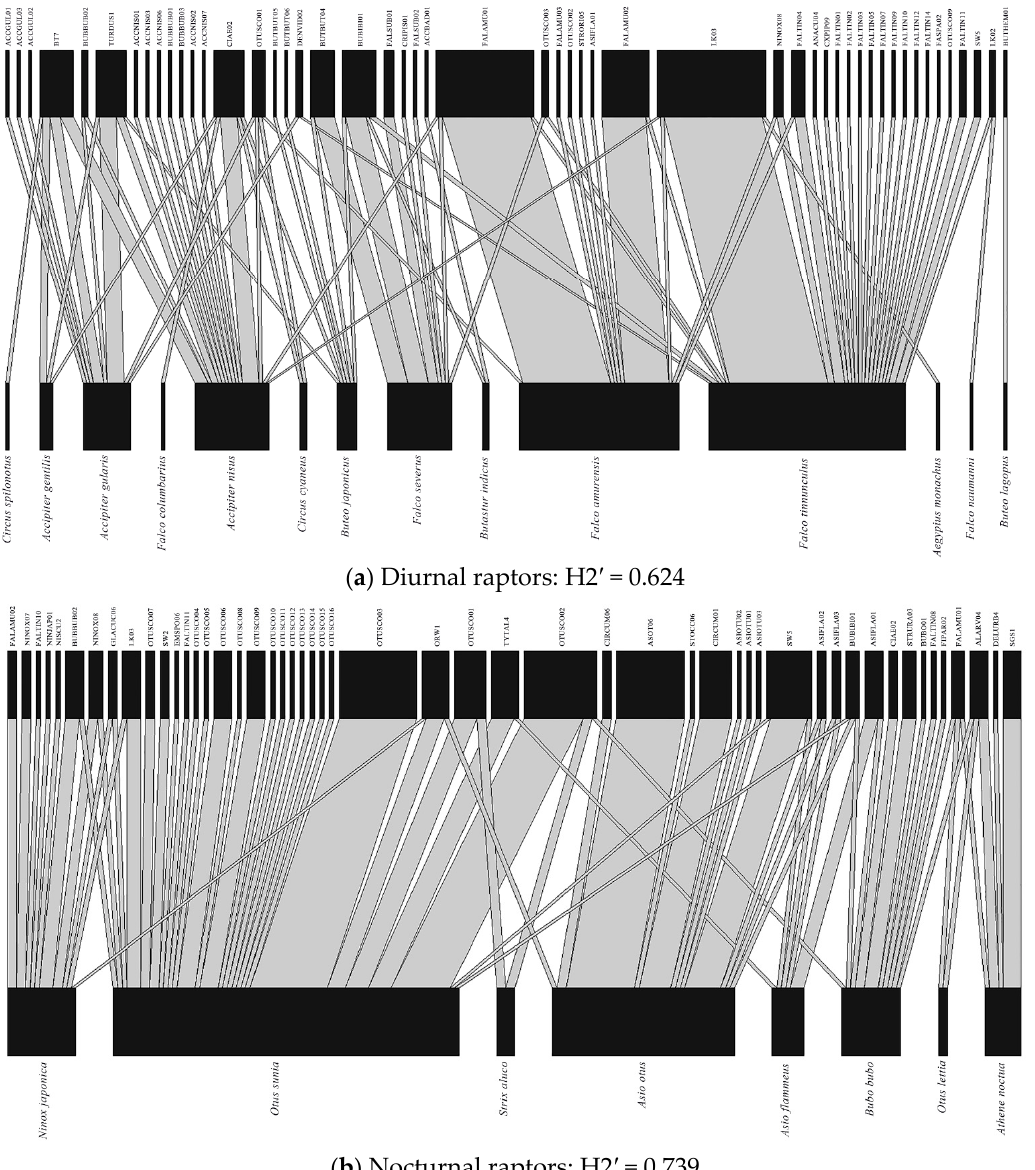
Figure 2. Host-parasite networks of comparable avian and haemosporidian communities in the diurnal ( a ) and nocturnal raptors ( b ). The network-level specificity index (H2 ′ ) is shown above each network. The width of each link corresponds to the number of interactions between a particular host and haemosporidian lineage.